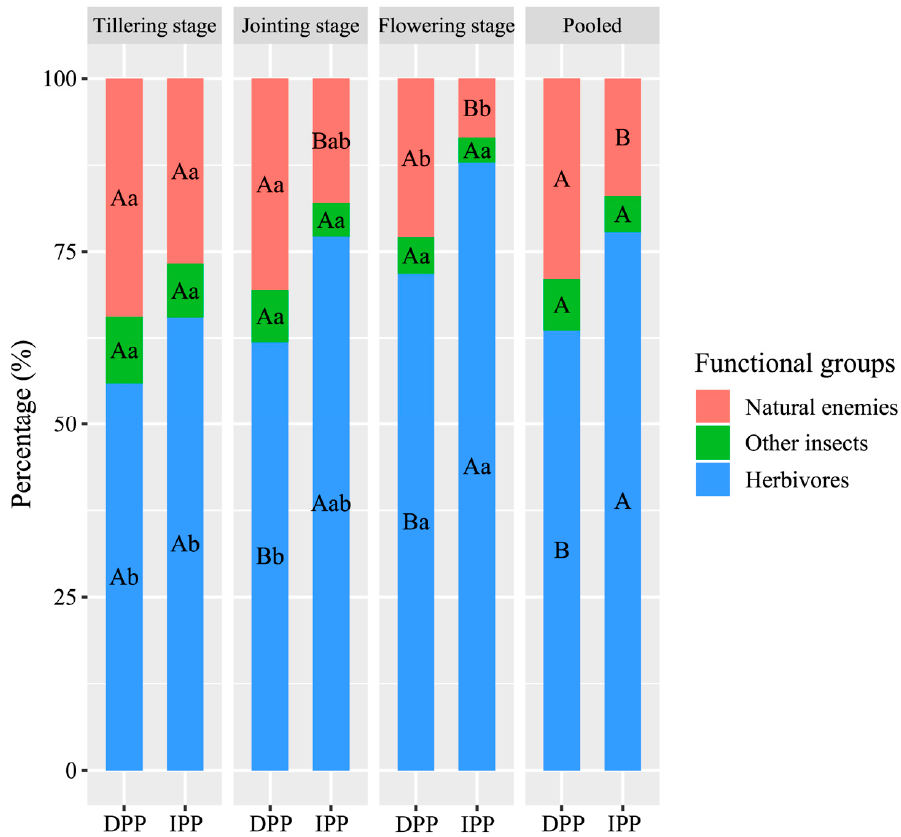
Figure 4. Percentages of different functional groups at different growth stages and under different planting patterns. Values followed by different capital letters are significantly different between different planting patterns ( p < 0.05). Values followed by different lowercase letters are significantly different among growth stages ( p < 0.05). DPP, diversified planting pattern; IPP, intensive planting pattern. Table 2. Statistical results of linear mixed-effects models (LMMs) for the community structure indices of vegetation-dwelling arthropods in naked oat fields under different planting patterns. Significant p -values are printed in bold. Response